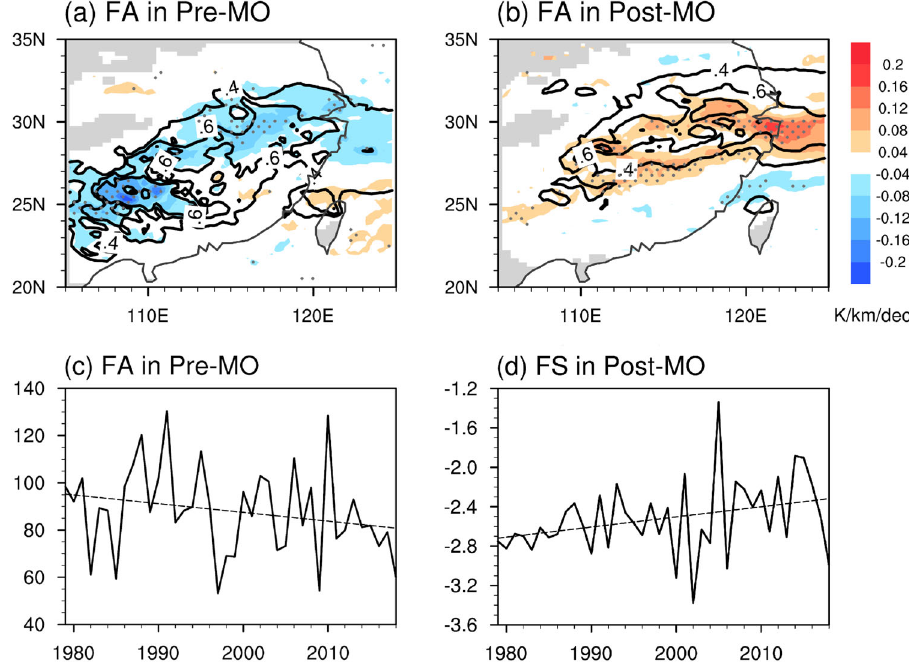
Fig. 2 Trends and variations in the characteristics of fronts. Trends of the accumulated frontal activity (FA) in a pre-MO and b post-MO periods during 1979 – 2018 (shading, K/km/decade). Contours show the corresponding climatology of each period (K/km). Time series of c FA index in the pre-MO period and d front stationarity (FS) index in the post-MO period over SC. Stippled areas in a and b are signi fi cant at the 0.05 level. Slanted straight lines in c and d represent the linear regression results, which are signi fi cant at the 0.1 and 0.05 levels, respectively.